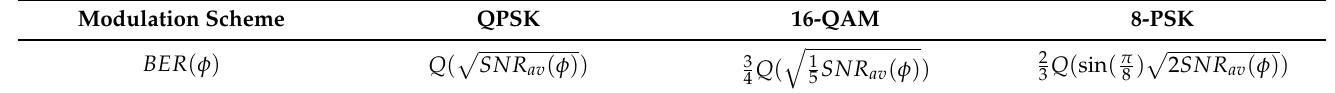
Table 2. BER for uncoded data over AWGN channels